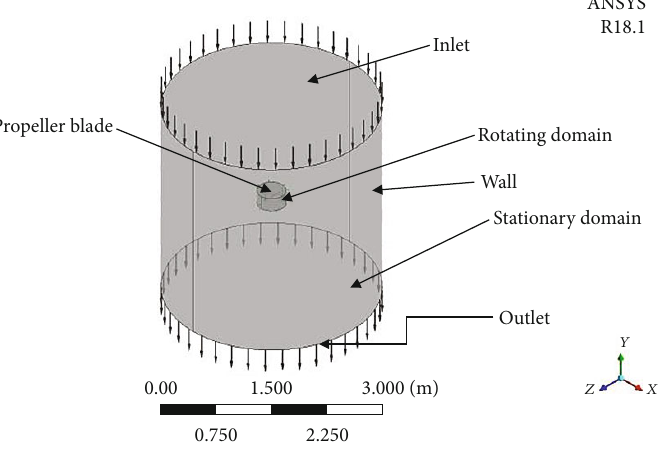
Figure 12: Computational domain and boundary conditions.